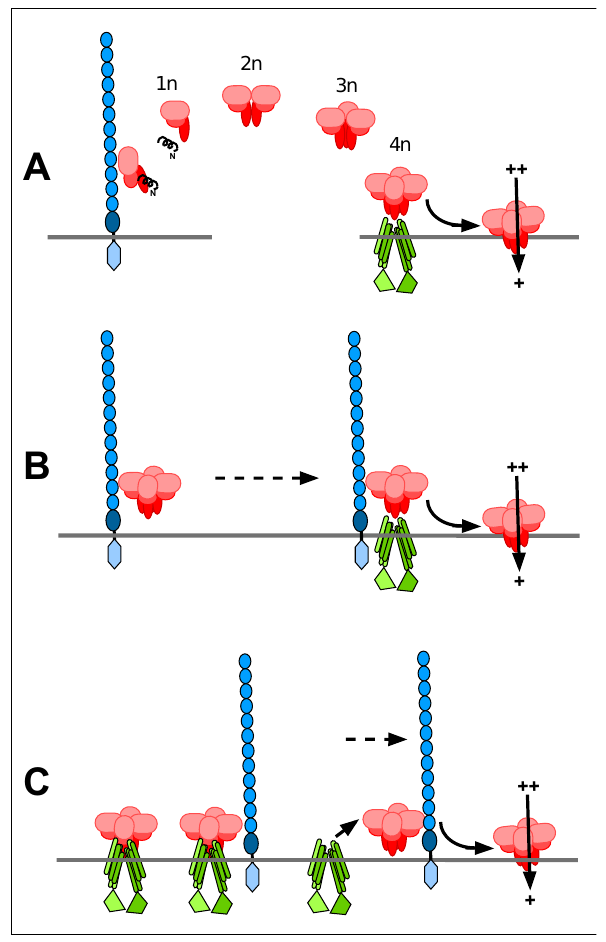
Figure 3. Hypothetical models of the mechanism of synergy between the 12-cadherin domain protein and an ABC transporter. ( A ) Trans -acting synergy, due to acceleration of oligomer formation following monomer binding to the cadherin. ( B ) Cis -acting synergy, due to the cadherin trapping the pre-pore and moving it to the ABC transporter. ( C ) Cis -acting synergy, due to the cadherin pulling the pre-pore away from the ABC transporter, freeing it to interact with another toxin pre-pore. Dotted lines represent movement of the cadherin within the